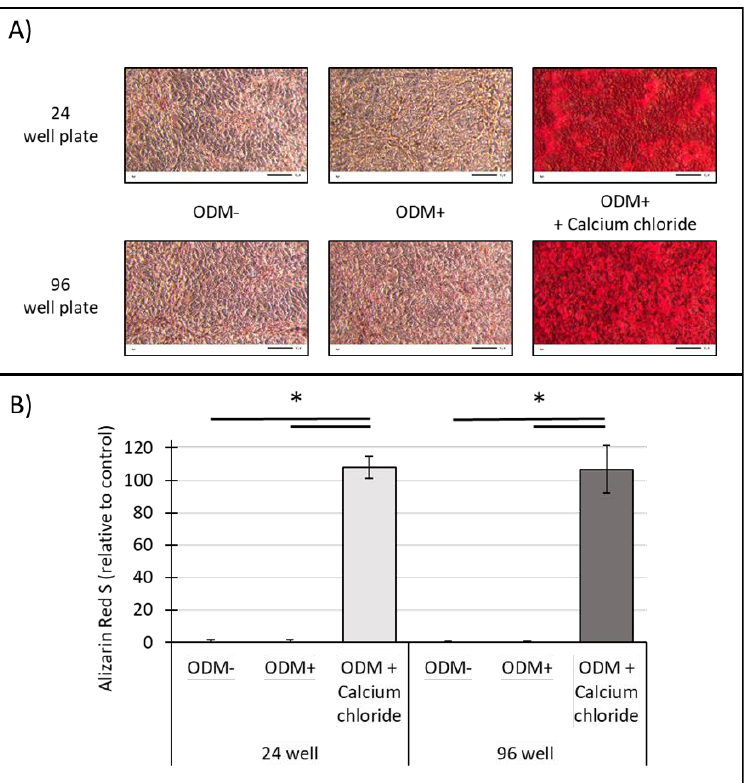
Figure 6. Effect of well size on alizarin red S staining of human SaOs-2 osteoblasts. Human osteoblasts were stimulated with osteoblast differentiation medium (ODM+) and in combination with calcium chloride (5 mM) in 24- or 96-well plates for three weeks before alizarin red S staining was performed. ODM− served as a negative control. ( A ) Representative pictures of alizarin red S-stained SaOs-2 osteoblasts assessed with transmitted light microscopy at 20x magnification are shown. Scale bar is 50 µm. ( B ) Concentrations of alizarin red S were calculated photometrically and are represented relative to the ODM+ reference of the 96-well plate. Means ± standard deviation from three independent experiments using sextuplicates are shown. * Indicates a significant difference ( p < 0.001).